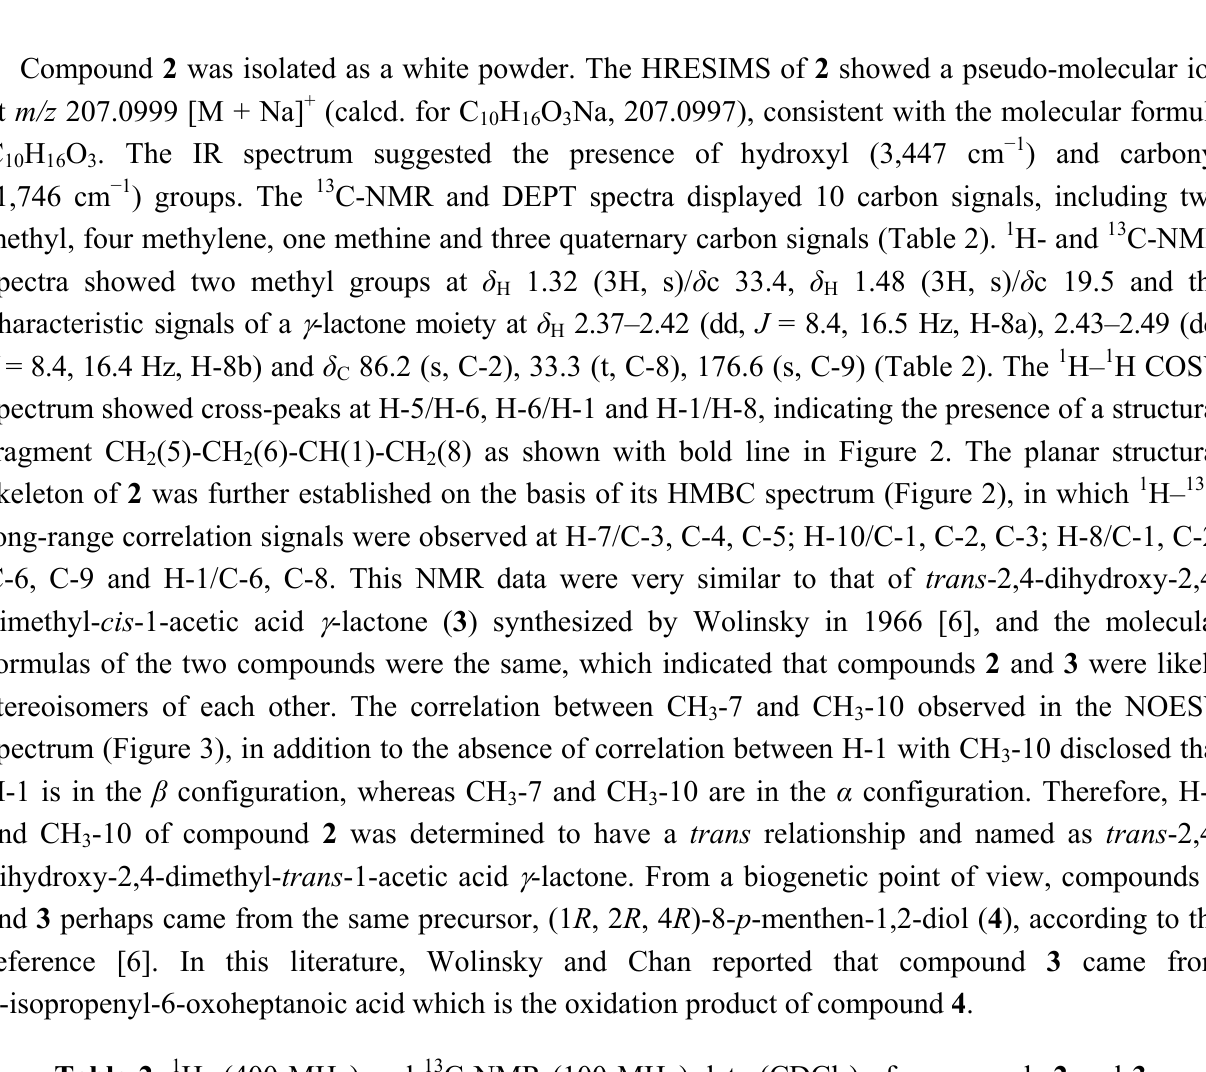
) of compounds 2 and 3 . 3